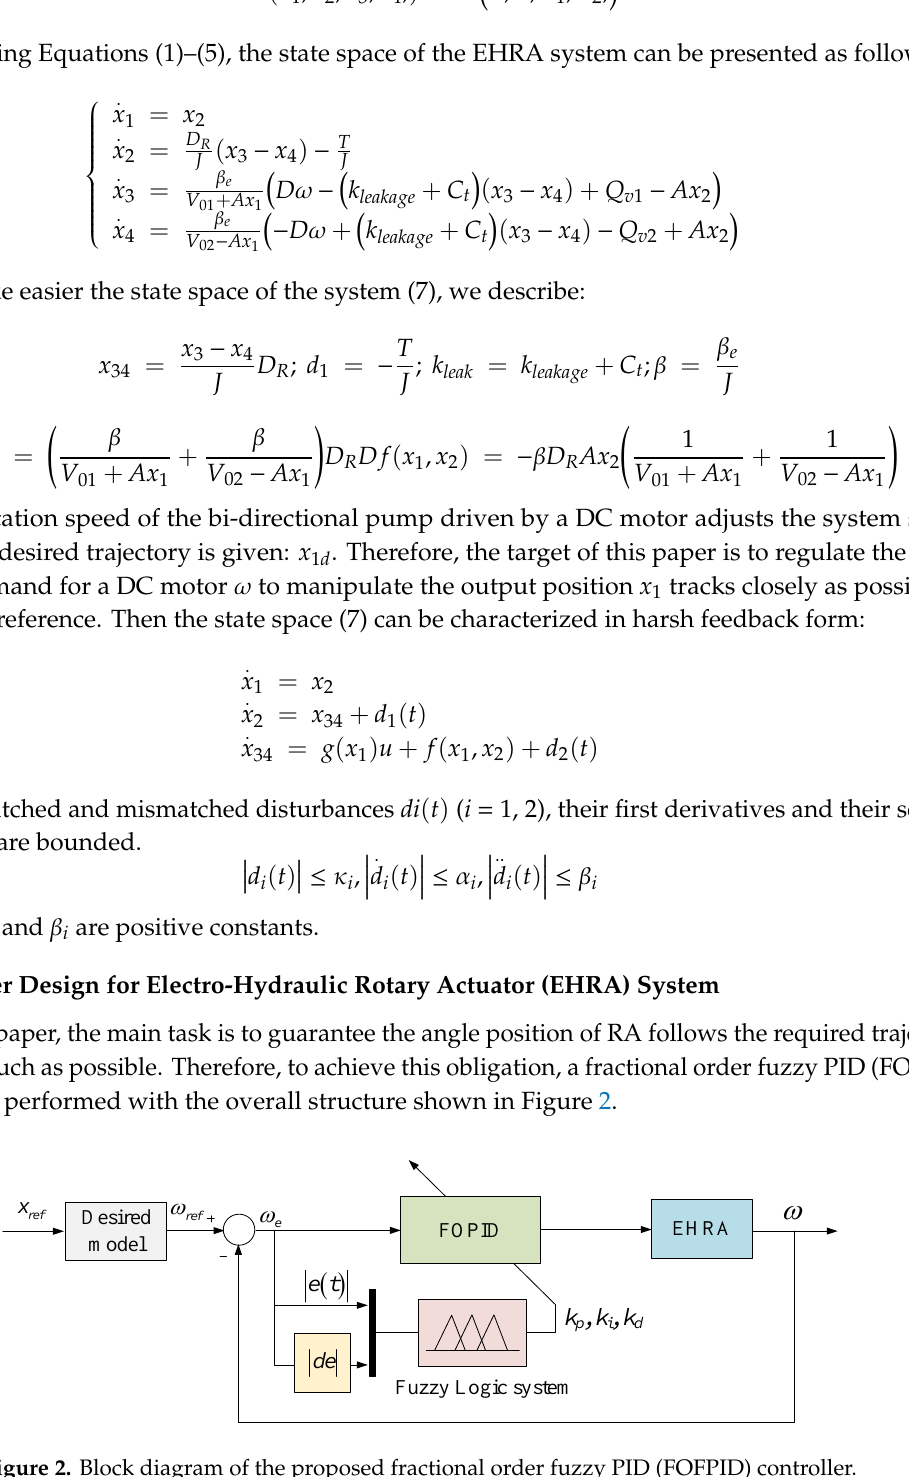
Figure 2. Block diagram of the proposed fractional order fuzzy PID (FOFPID) controller.